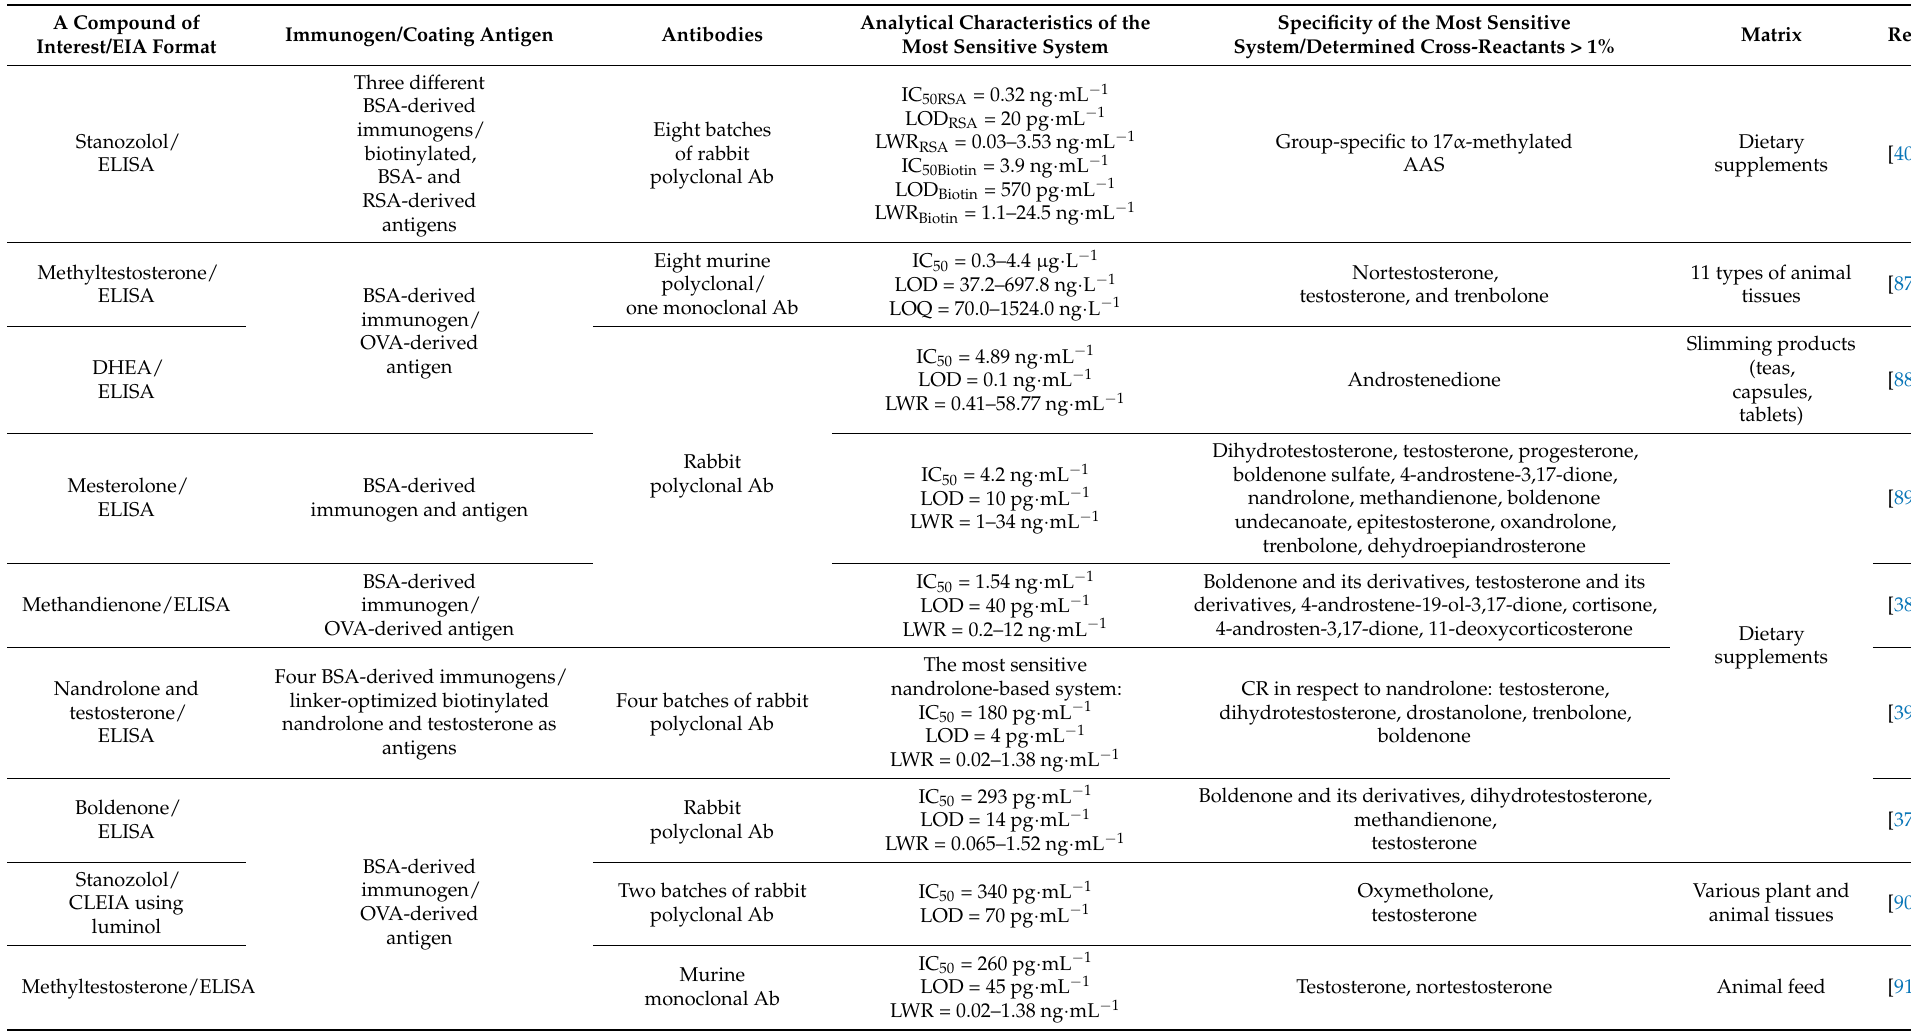
Table 2. Enzymatic immunoassays for the determination of anabolic-androgenic